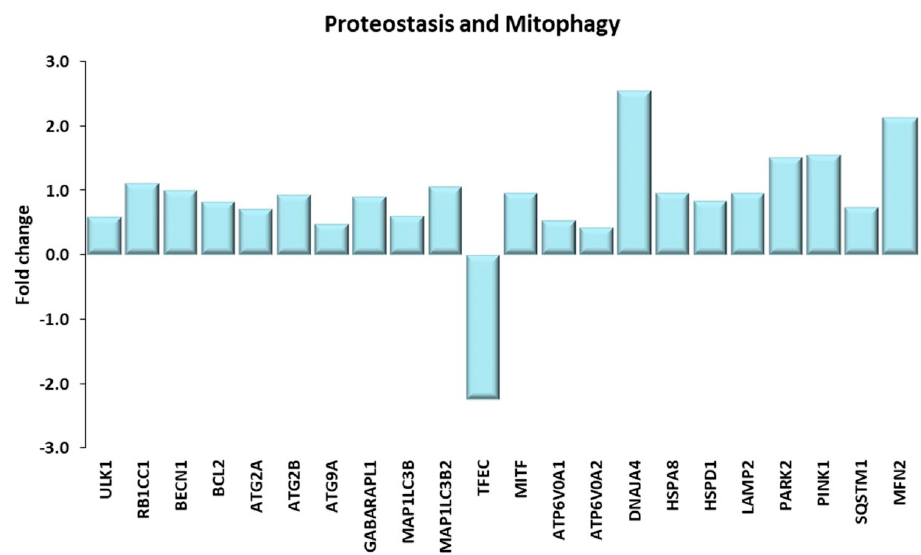
Figure 10. Proteostasis and Mitophagy. Genes discussed in the text are shown here as fold change in the comparison of TRA and SED subjects. ULK1: unc-51 like autophagy activating kinase 1; RB1CC1: RB1 inducible coiled-coil 1 or FIP220; BECN1: beclin1; BCL2: BCL2 apoptosis regulator; ATG2A, ATG2B, ATG9A: autophagy related 2A, 2B, 9A. GABARAPL1: GABA(A) receptor-associated protein like 1; MAP1LC3B, MAP1LC3B2: microtubule associated protein 1 light chain 3 β , β 2; TFEC: transcription factor EC; MITF: melanocyte inducing transcription factor; ATP6V0A1, ATP6V0A2: ATPase H + transporting V0 subunit A1, A2; DNAJA4: DnaJ heat shock protein family (Hsp40) member A4; HSPA8: heat shock protein family A (Hsp70) member 8; HSPD1: heat shock protein family D (Hsp60) member 1; LAMP2: lysosomal associated membrane protein 2; PARK2: parkin RBR E3 ubiquitin protein ligase; PINK1: PTEN induced kinase 1; SQSTM1: sequestosome 1 or p62; MFN2: mitofusin